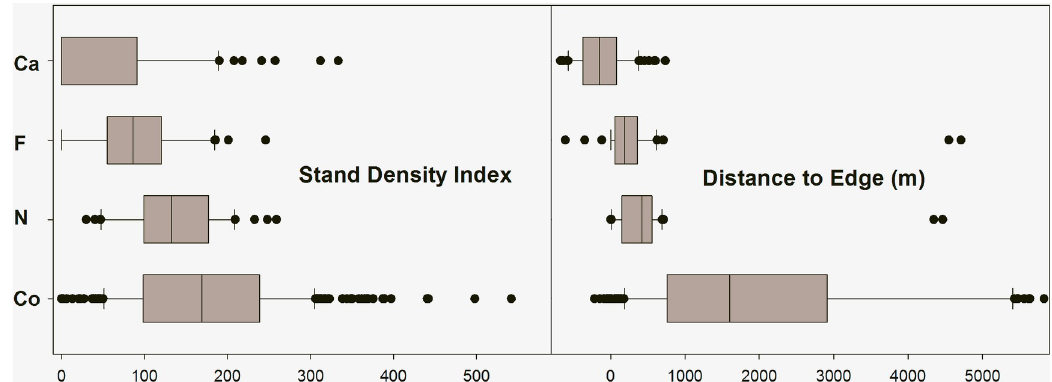
Fig 6. Box plots for additional habitat attributes. Box plots for two habitat attributes not used in logistic regression models, as described in Table 2. The median and lower quartile are visually indistinguishable in the Stand Density Index attribute for Pinyon Jay caching locations. Y-axis codes are Co = control sites, N = Pinyon Jay nesting locations, F = Pinyon Jay foraging locations, and Ca = Pinyon Jay caching locations. For better visual clarity, the extreme high range of observed Distance to Edge values (6,000– 12,000 m) values are truncated, omitting a small number of outlier Co